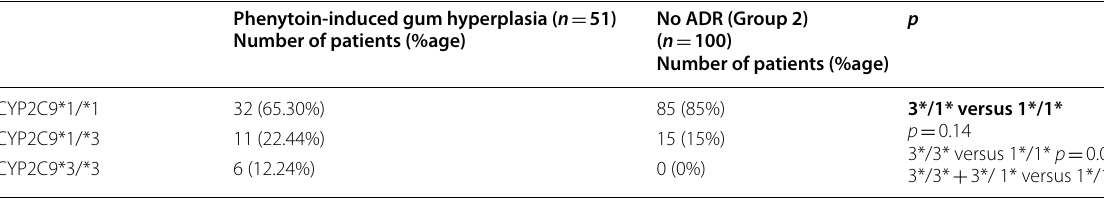
Patients with drug-related ADRs (both idiosyncratic and